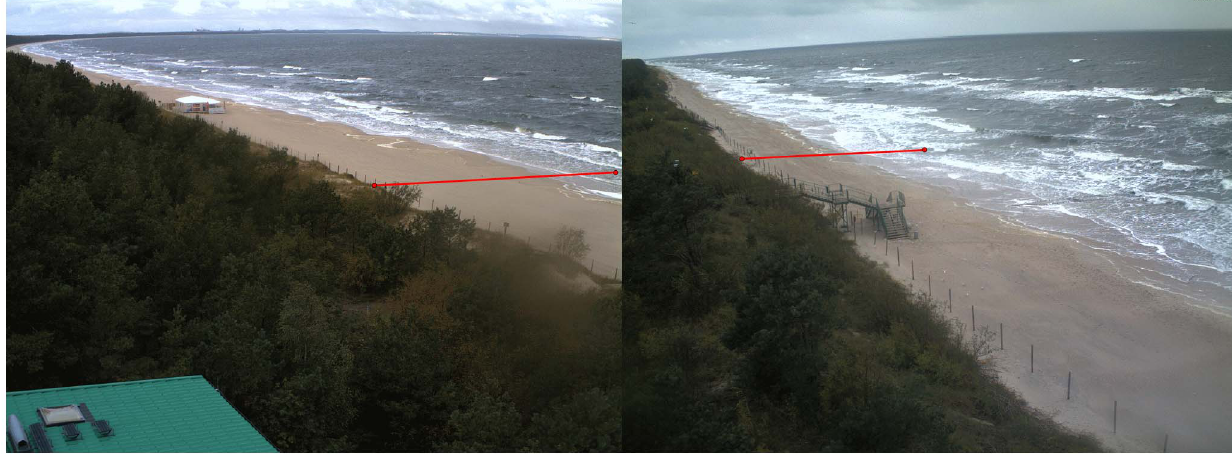
Figure 2. View from cameras in Mie˛dzyzdroje (left) and Dziwno´wek (right). Cross-sections are marked in red.